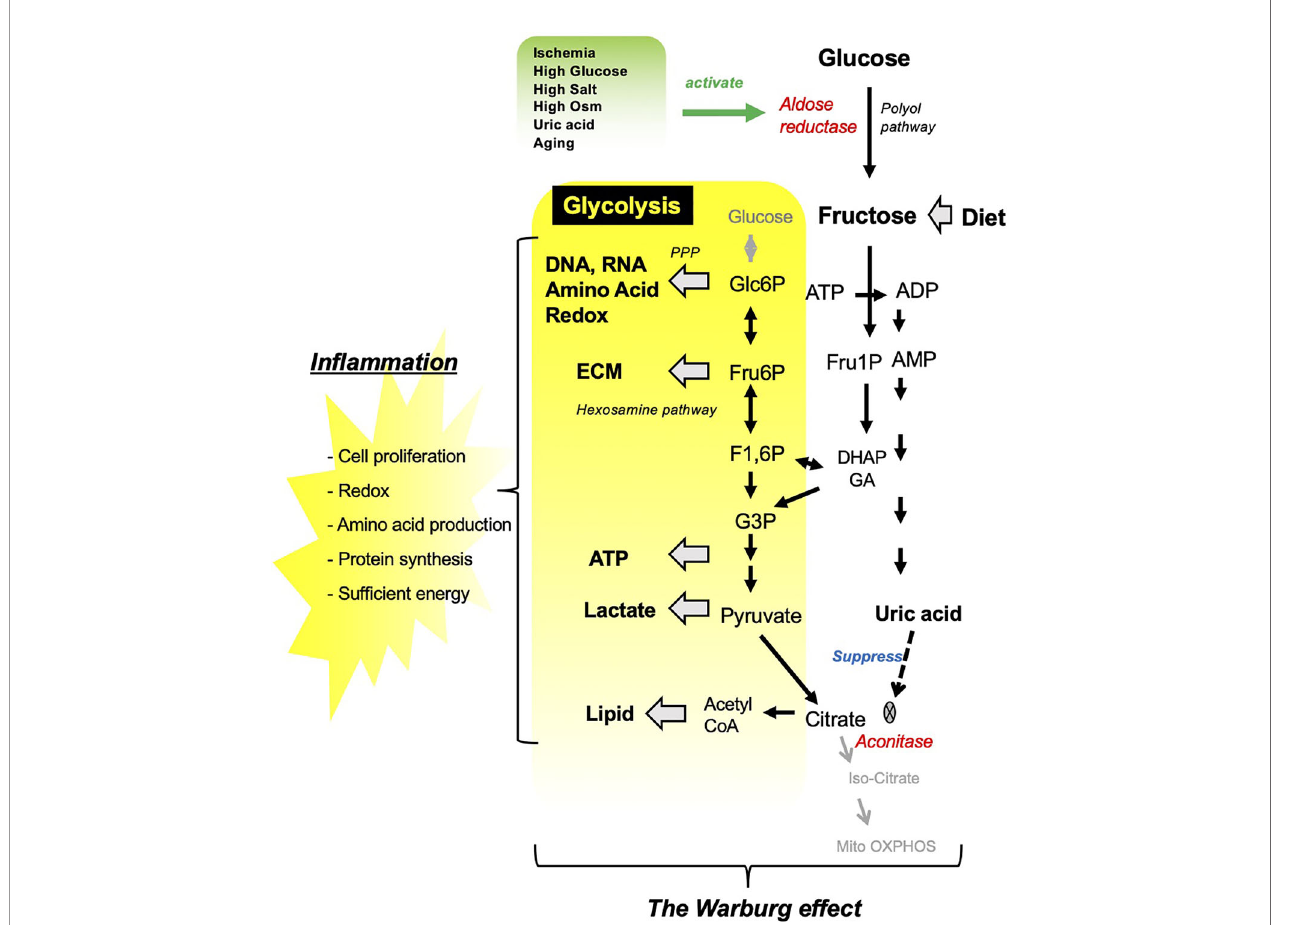
FIGURE 1 | Fructose metabolism resembles the Warburg effect. Several pathological conditions stimulate aldose reductase, which converts glucose into fructose in the kidney. Fructose either from diet or from endogenous system under pathological condition is converted by fructokinase into Fructose 1-phosphate, which channels into glycolytic pathway. In turn, fructose metabolism results in uric acid production as a by-product, which suppress TCA cycle by inhibiting aconitase. ECM, extra cellular